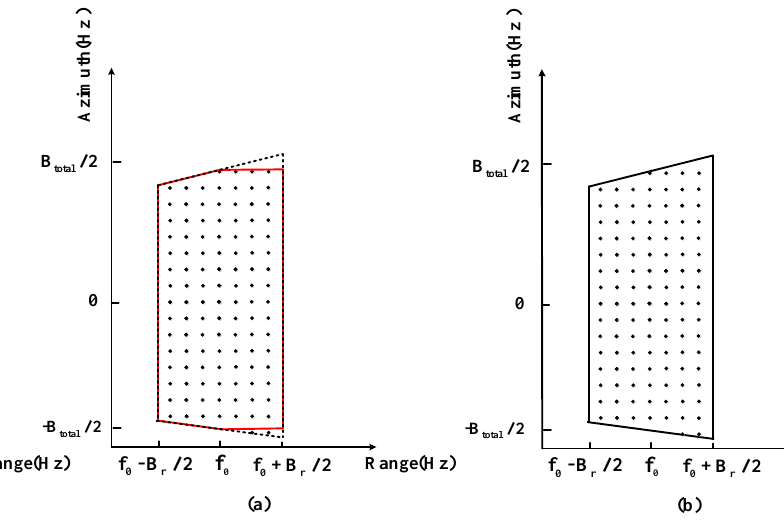
Figure 8. Conducting the weighting operation in the range frequency domain. The figure shows the spectrum in the two-dimensional frequency domain after a deramping operation. ( a ) Using the former weighting bandwidth B ar ≈ 2 V s · β / λ , the red line shows the residual two-dimensional frequency spectra after the weighting operation, while the black dotted line shows the spectrum without the weighting operation. ( b ) Using the new bandwidth B ar ( f r ) ≈ 2 V s · β / c · ( f 0 + f r ) while updating f r in the range frequency domain.